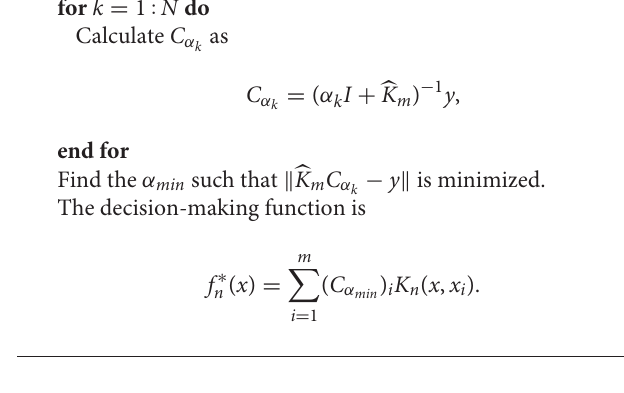
TABLE 1 | Results of testing for two moons